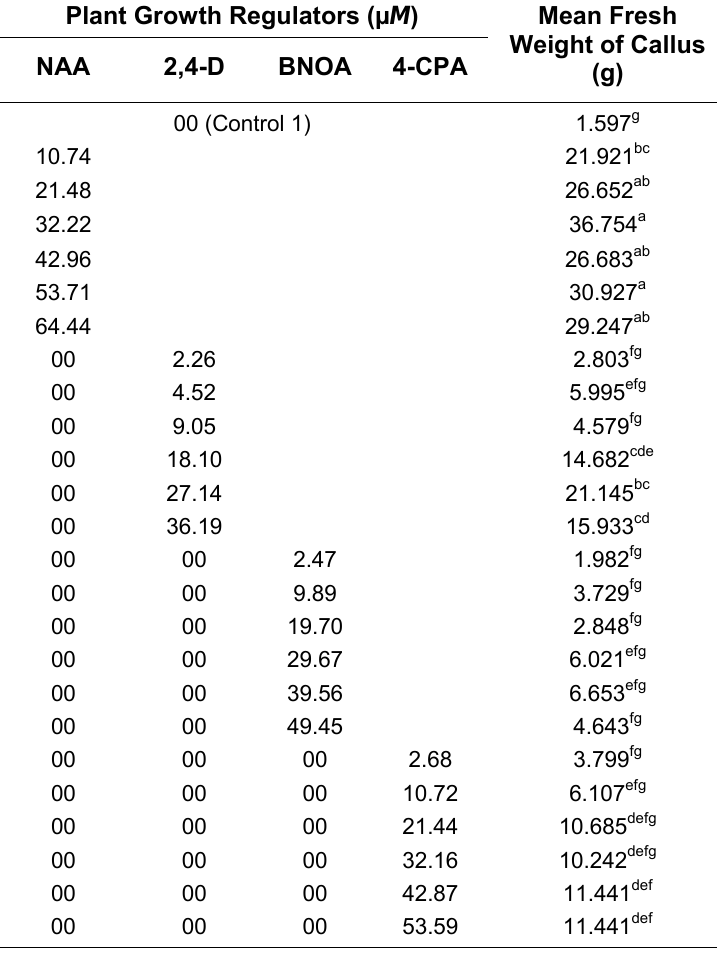
Effect of Different Auxins in Proliferation of 18-Month-Old Callus Plant Growth Regulators (µ M